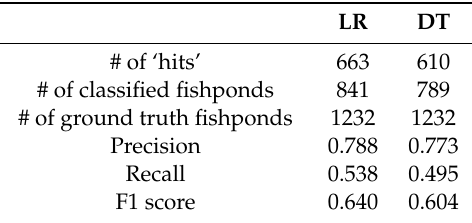
Table 6. Evaluation of LR and DT on the test